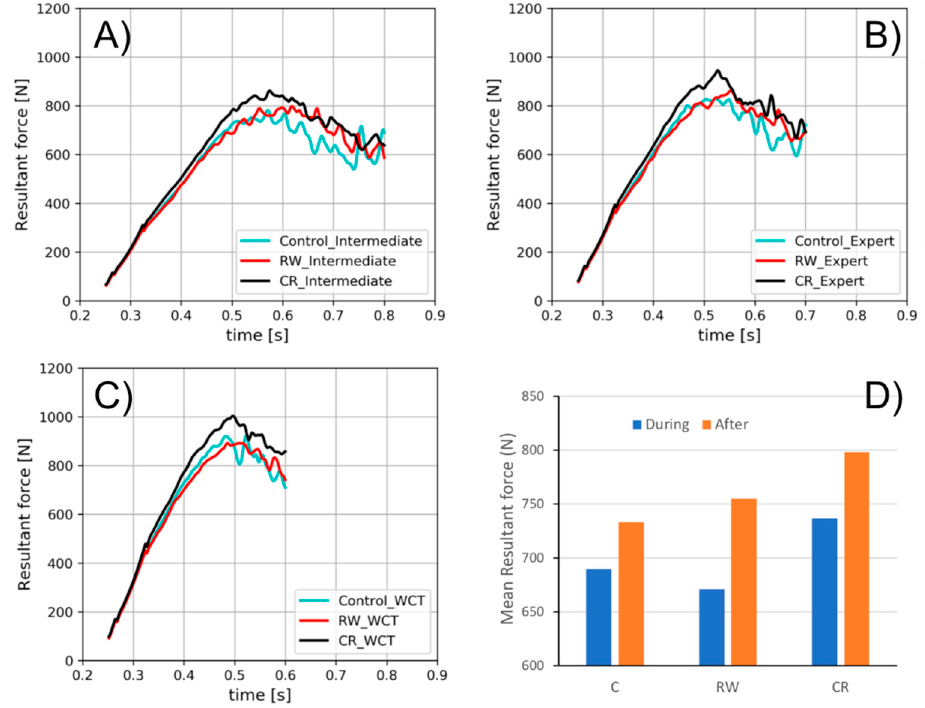
Figure 3. Time series of rider direction resultant forces for all fins during cutback maneuvers at intermediate, expert and professional (WCT) level. All turns start at 0.25 s, with ( A ) intermediate ending at 0.8 s, ( B ) expert ending at 0.7 s, and ( C ) WCT ending at 0.6 s. See Table S3 for detailed resultant forces and direction means. ( D ) Mean resultant force during (0.3 to 0.5 s) and after a WCT level cutback maneuver. C, RW and CR indicate control fins, fins with tubercles, and grooved fins,